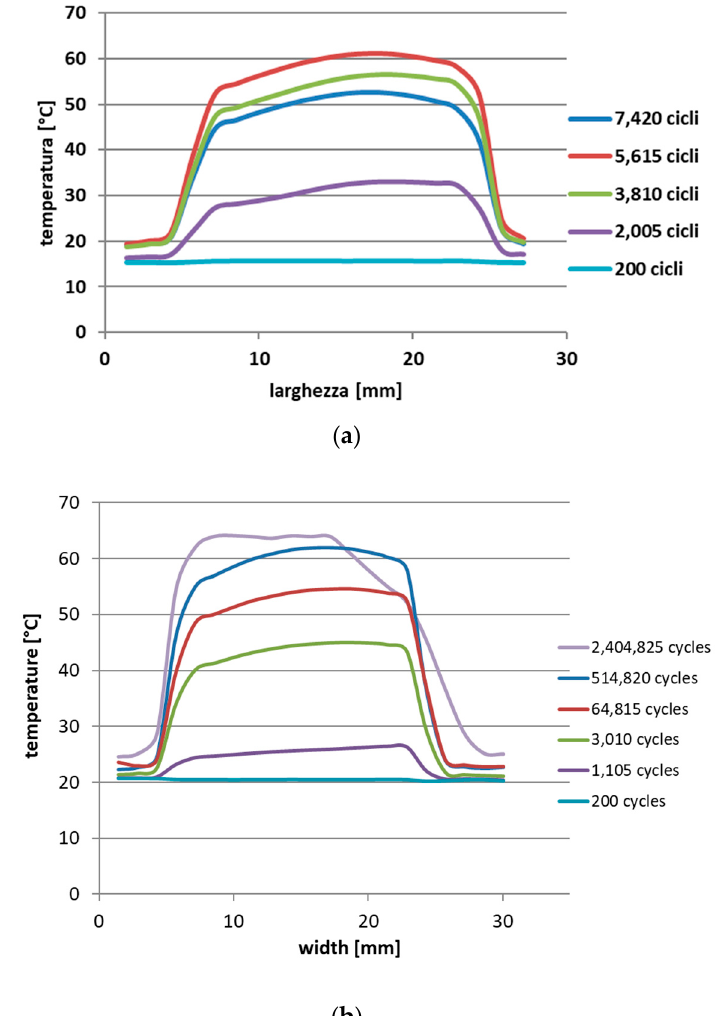
Figure 11. Spatial trend of the thermal profile at different load cycles: ( a ) specimen 1b; ( b ) specimen 14b.